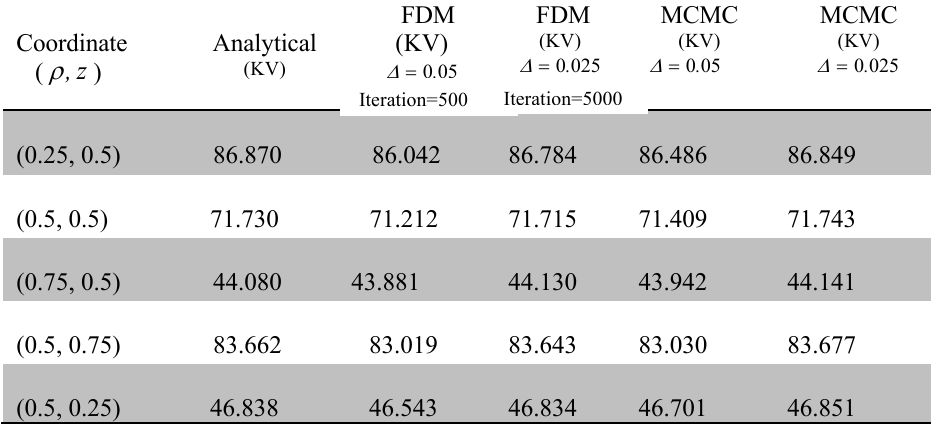
Table 2. Comparison for Analytical, FDM and MCMC for Poisson’s Equation in Axisymmetric Homogeneous